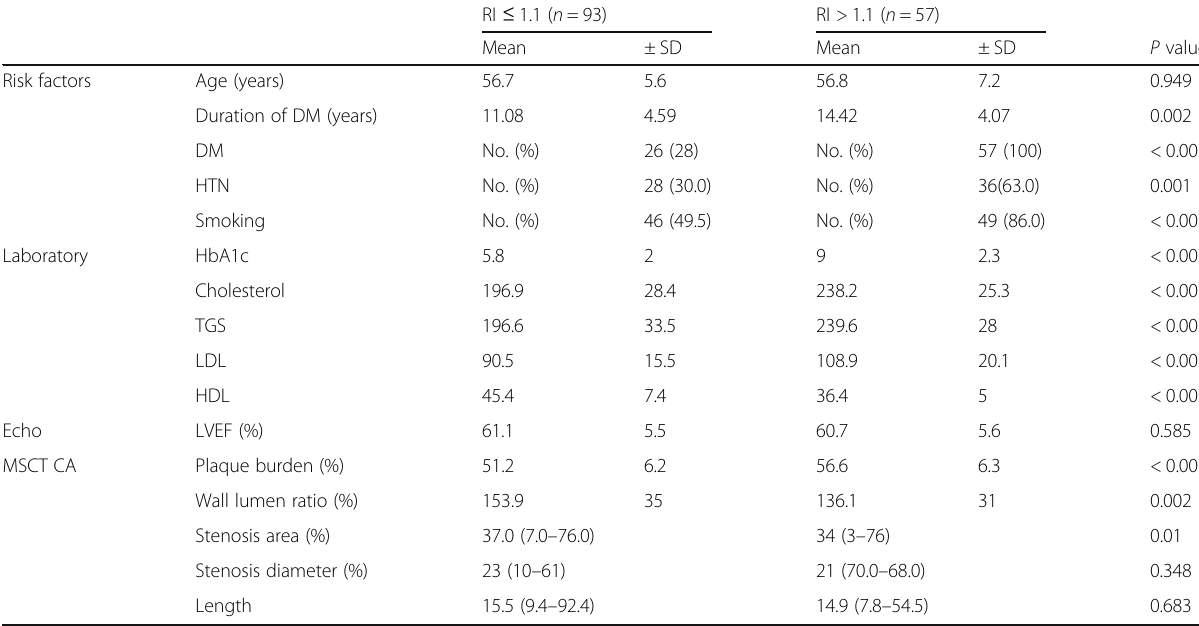
Table 3 Comparison between variables with RI ≤ 1.1 and >